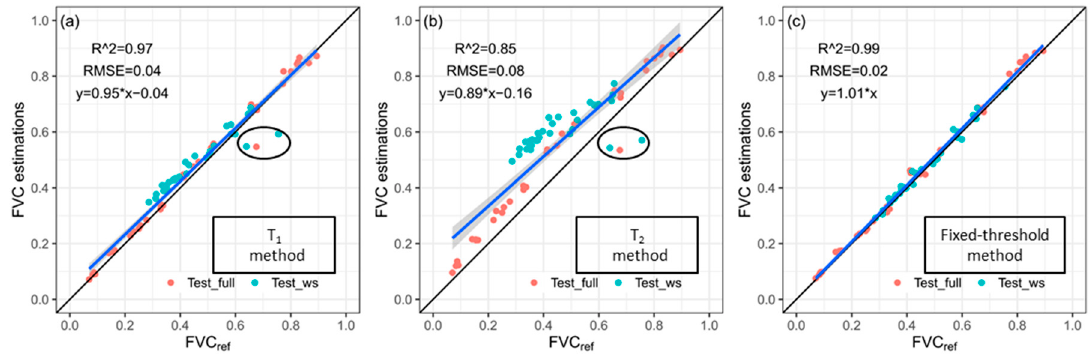
Figure 7. FVC estimation results obtained using ( a ) T 1 method, ( b ) T 2 method, and ( c ) fixed-threshold method on the a*_I color feature of the test image group (Test_full and Test_ws).